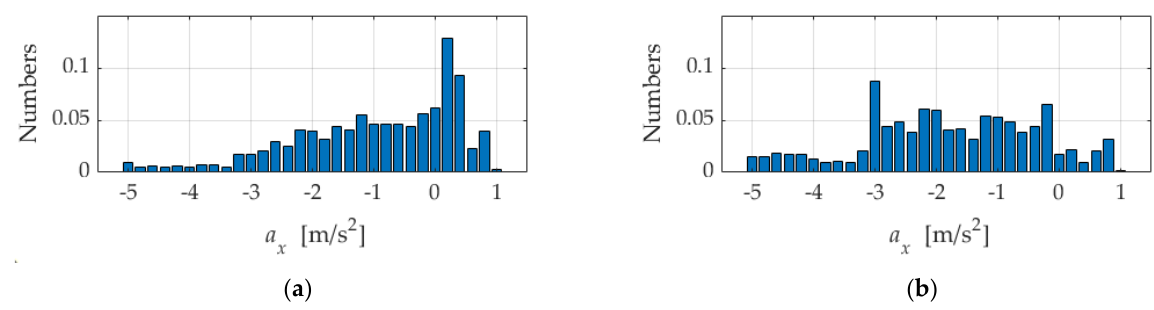
Figure 16. Acceleration usage comparison: ( a ) Proposed algorithm; ( b ) base algorithm.